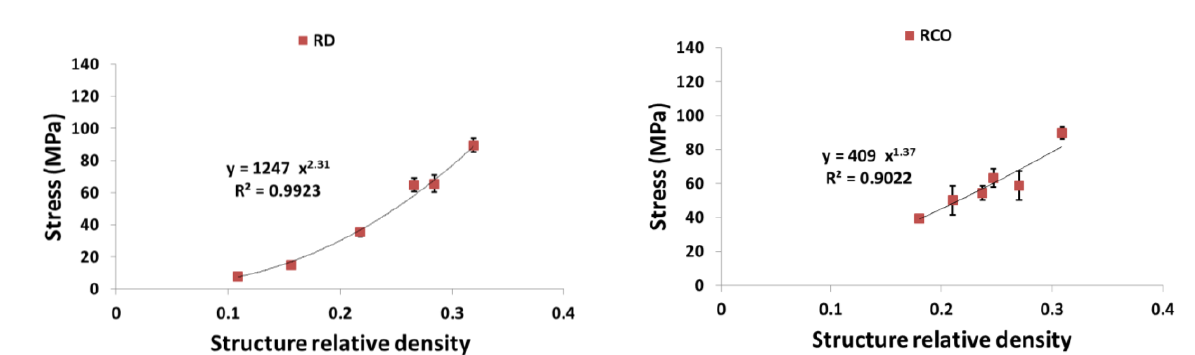
Figure 12. Summary of the yield stress results for porous structures based on different types of unit cell configurations (cubic (C); diamond (D); truncated cube (TC); truncated cuboctahedron (TCO); rhombic dodecahedron (RD); rhombicuboctahedron (RCO)) and different structure relative densities (see Table